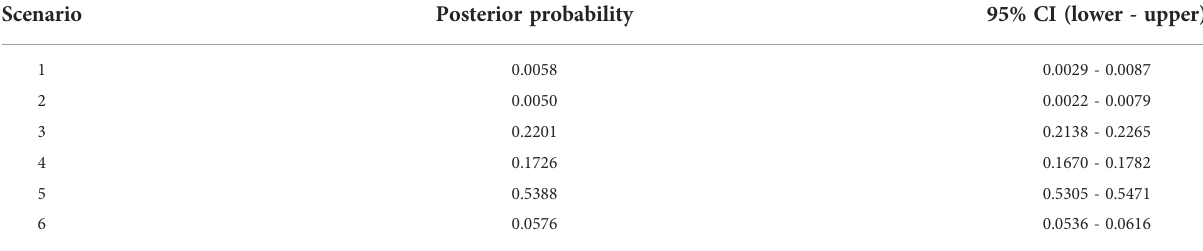
TABLE 2 Posterior probability of each scenario and its 95% con fi dence interval based on the logistic estimate by DIYABC.